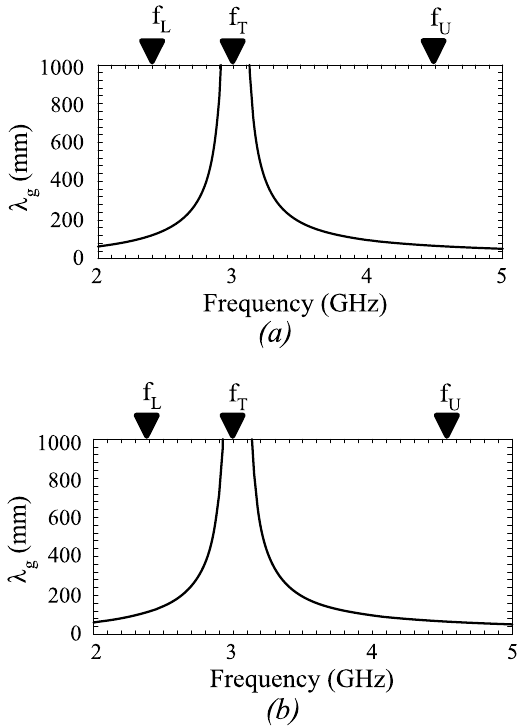
Fig. 4. Guided wavelength l g for the unit cell as a function of frequency. (a) C-type metaline. (b) N-type